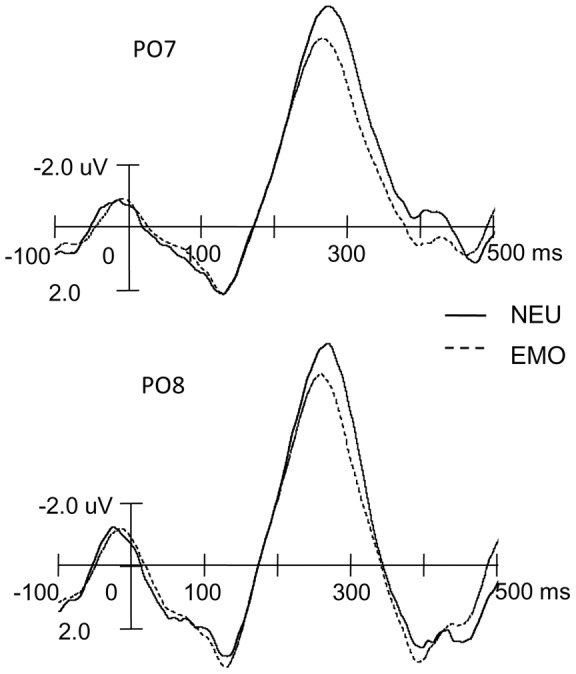
The comparison between neutral (NEU) and other emotional states (EMO).